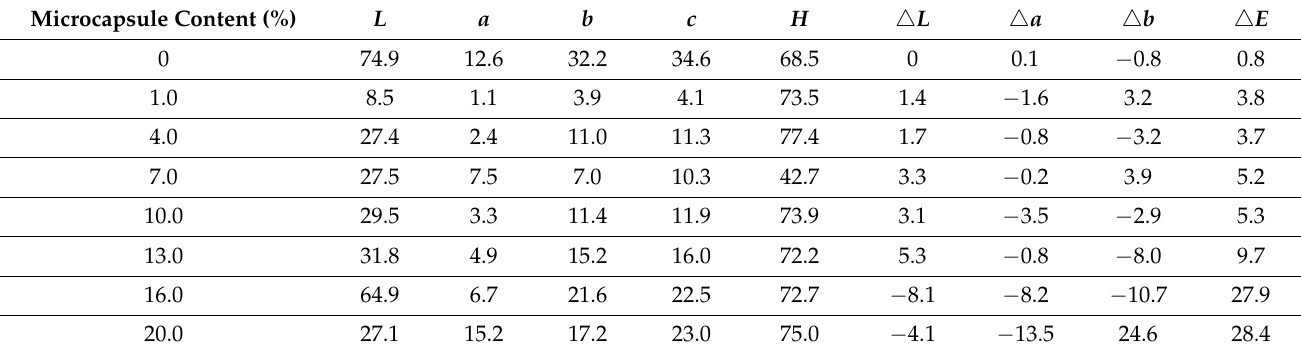
Table 7. Color values of the coatings with core-wall ratio of 0.40.